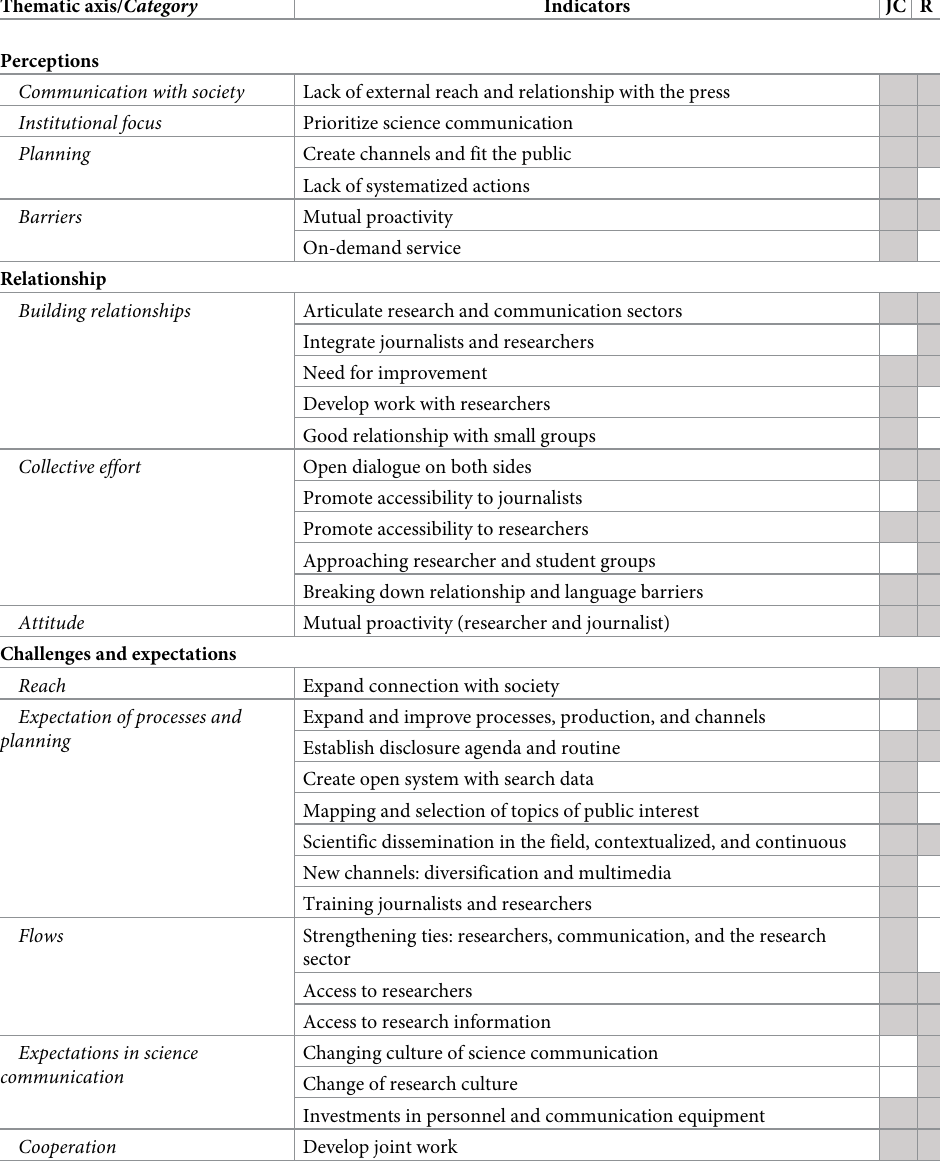
Table 3. Final categorization by thematic axis and by